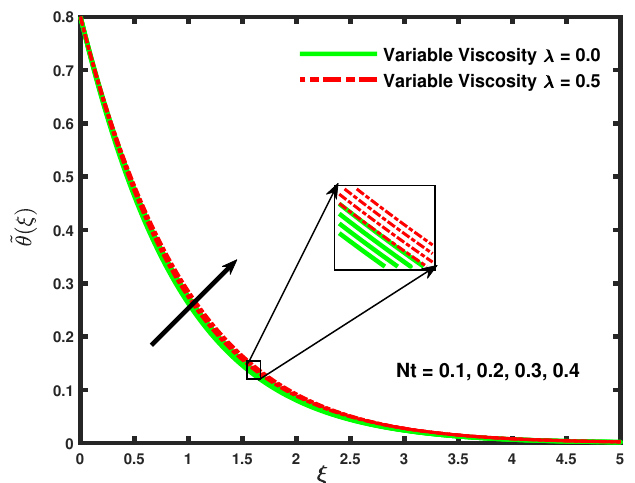
Figure 11. The influence of thermophoresis parameter ( Nt ) on Temperature